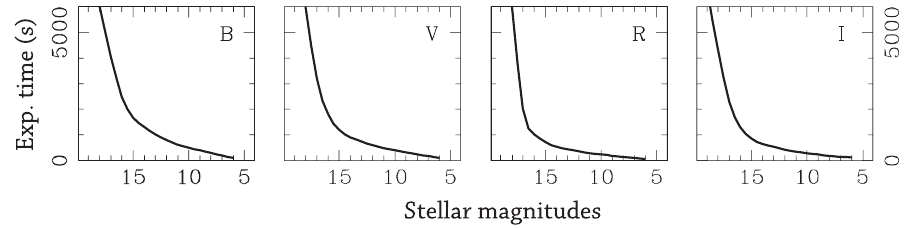
Fig. 9. Typical exposure times, in the various passbands, as a function of the target magnitude for a 30 cm aperture ANS telescope. BV R C I C photometric runs of symbiotic stars. Only a small fraction of